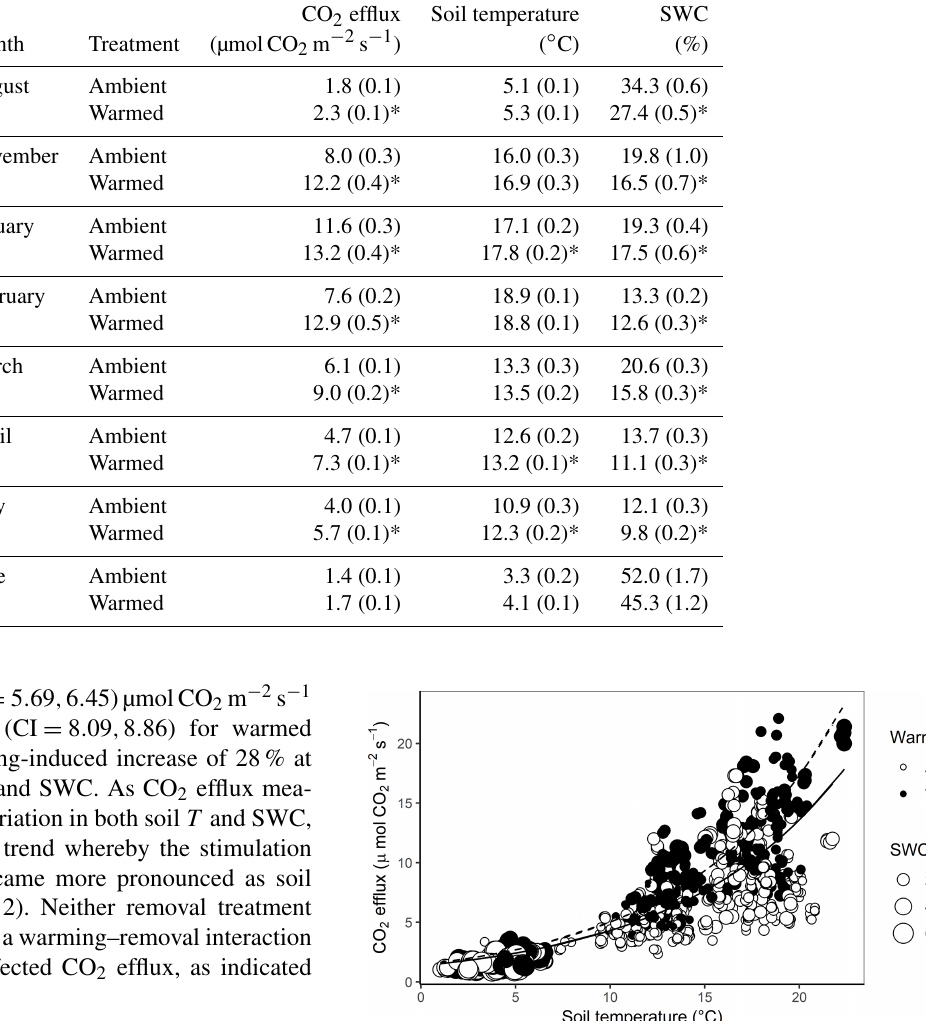
Table 1. The impact of experimental warming on soil CO 2 efflux, soil temperature, and soil water content in the Silver Plains warming experiment from August 2017 to June 2018. Values shown are means with standard errors in parentheses ( n = 20) Asterisks next to warmed means indicate significant differences ( P< 0 . 05) between means of warmed and ambient plots within a month. CO 2 efflux Soil temperature